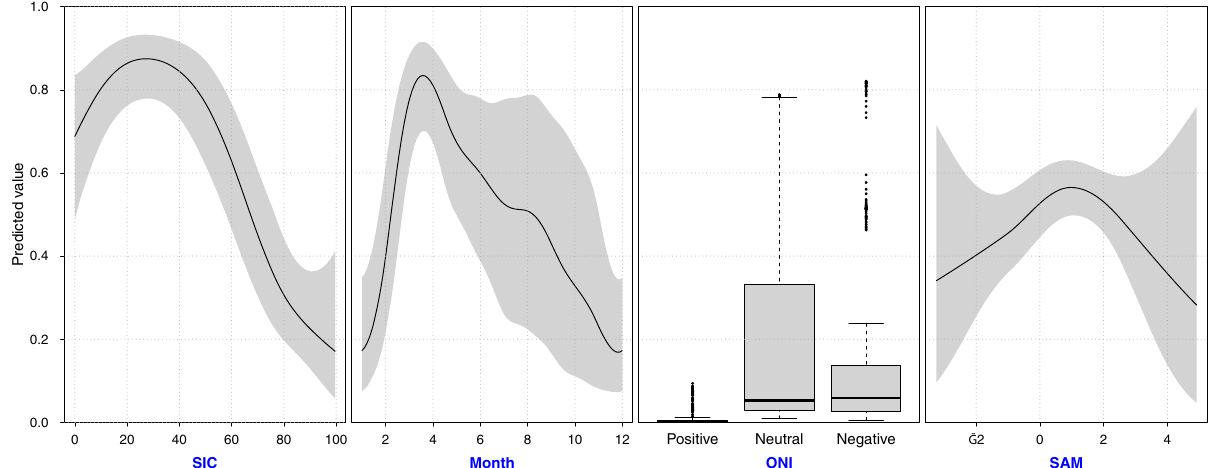
Fig. 3 Humpback whale acoustic presence modeled as a function of SIC, SAM, and ONI. Model predictions of the best- fi t model for the acoustic presence of humpback whales at stations G3/G4, including the smooth terms SIC, month, and SAM as well as ONI as a categorical predictor (see “ Methods ” for further explanation of categories). Gray-shaded areas in line plots depict 95%-con fi dence intervals ( n = 2629 days of